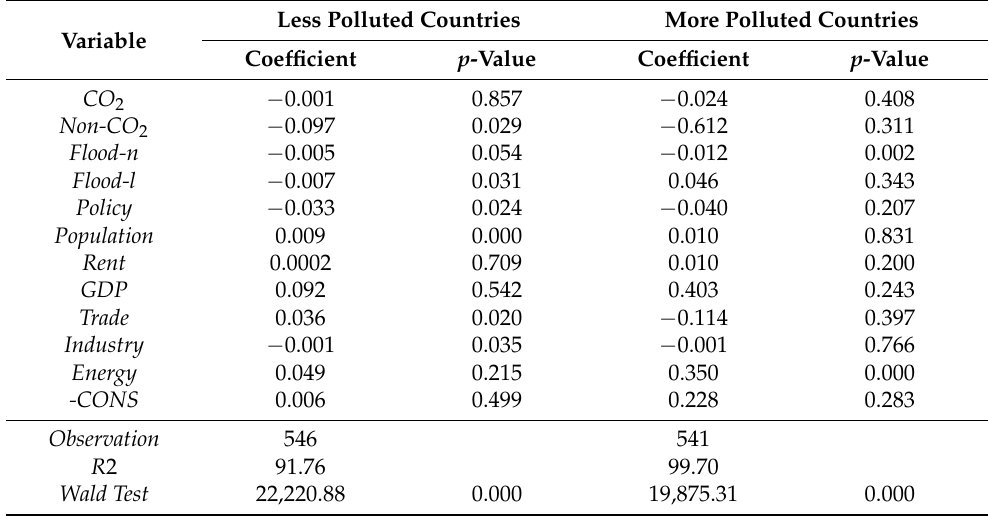
Table 7. Estimation results for the solar energy sector in more polluted and less polluted countries.